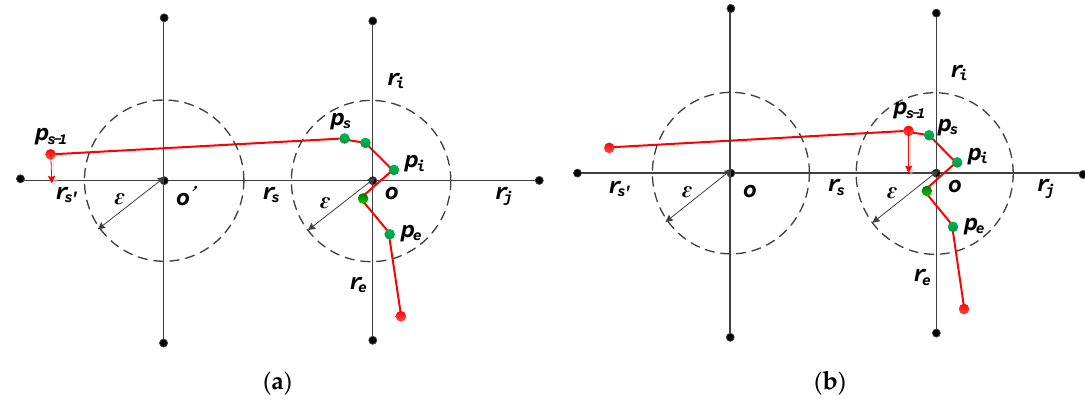
Figure 5. Matching of inbound road section with the previous point of the inbound point. Point p s is the inbound point, and Point p s- 1 is the previous point of the inbound point. ( a ) The relationship between the inbound point and its previous point in the form, and ( b ) the relationship between the inbound point and its previous point in actual processing.